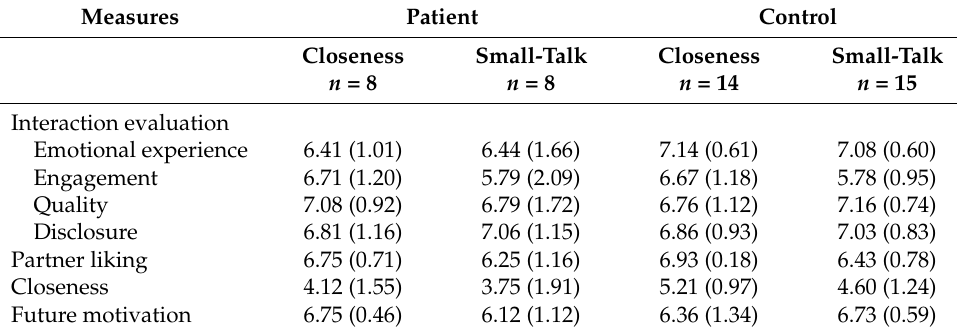
Table 2. Mean (standard deviation) of post-interaction